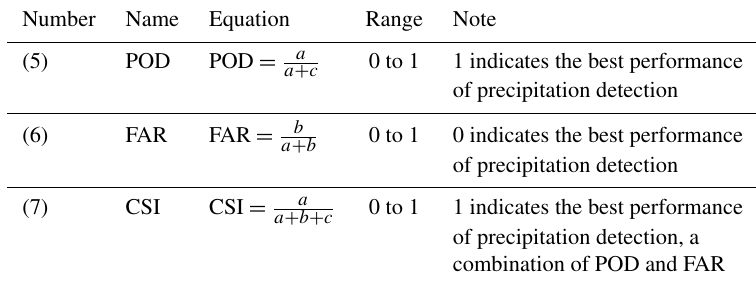
Table 2. Detection indices used in this study and their